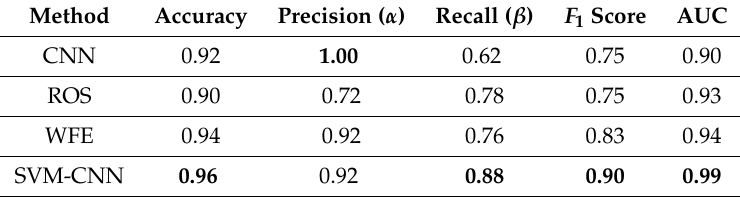
Table 4. Classification result comparisons. Bold values in the table denote the highest one in each attribute.